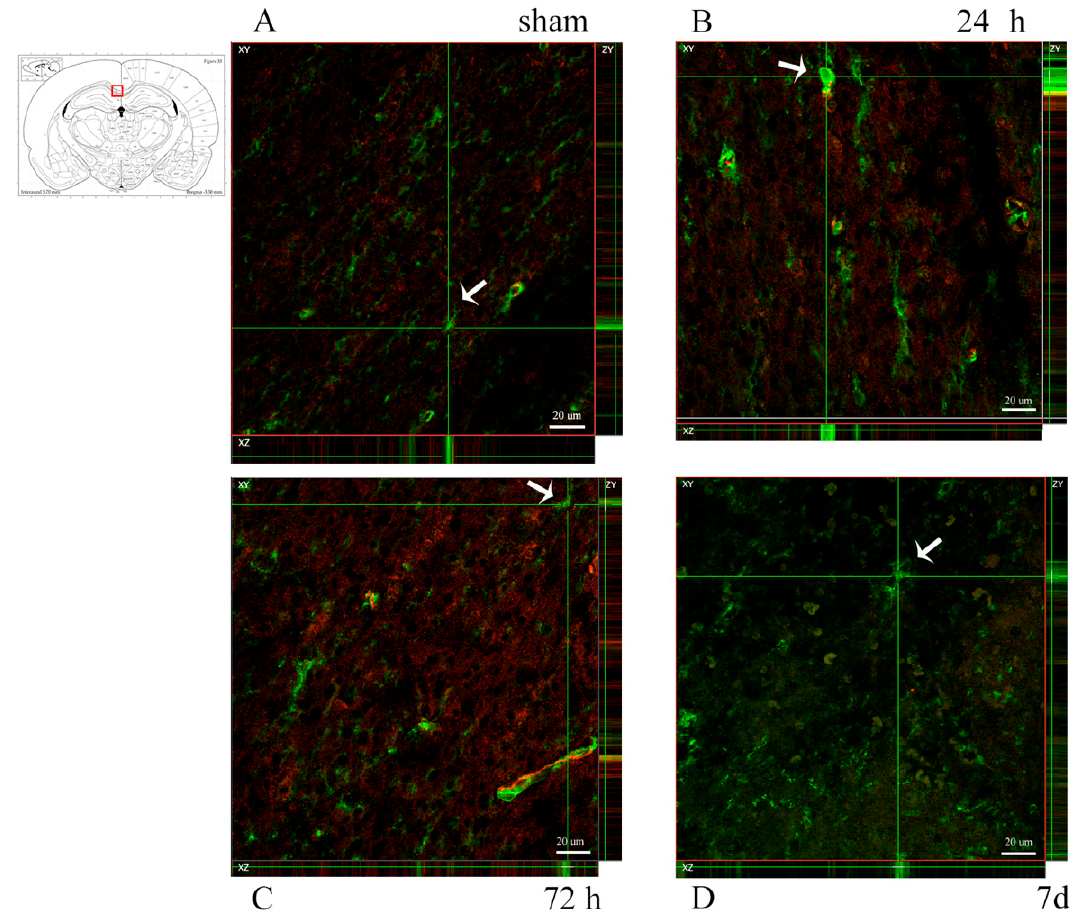
Figure 8. NG2 expression in the corpus callosum at around -3 mm from bregma. ( A – D ) Confocal microscopy photographs show NG2 + oligodendrocyte progenitor cells in the corpus callosum. Double staining with Occludin-1 (red) was done to distinguish NG2 + (green) vessel walls from OPCs. Arrows indicate OPCs as shown by the expression of NG2 on the XYZ planes. NG2 + OPCs are scattered throughout the corpus callosum, with no apparent di ff erence between sham and trauma-exposed subjects. Insert: the highlighted area refers to the area represented in ( A – D ). Scale bar = 20 µ m.